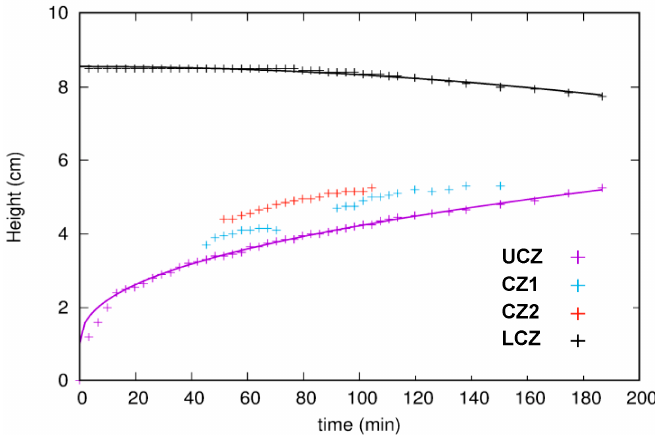
Figure 9. Time evolution of the interfaces between zones (symbols: predictions; lines: least-squares curve fit to the predictions).